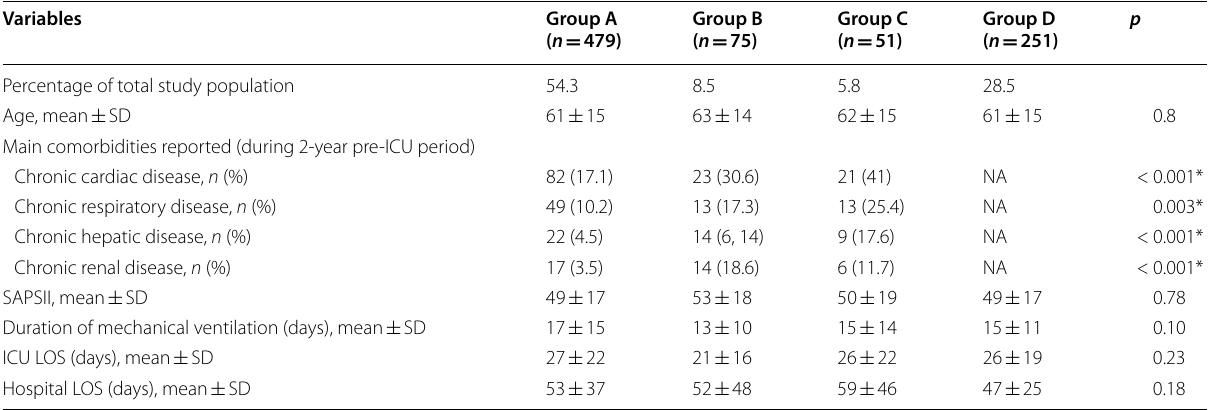
SAPSII simplified acute physiology score II of the index intensive care unit (ICU) stay, SD standard deviation, LOS length of stay, NA non